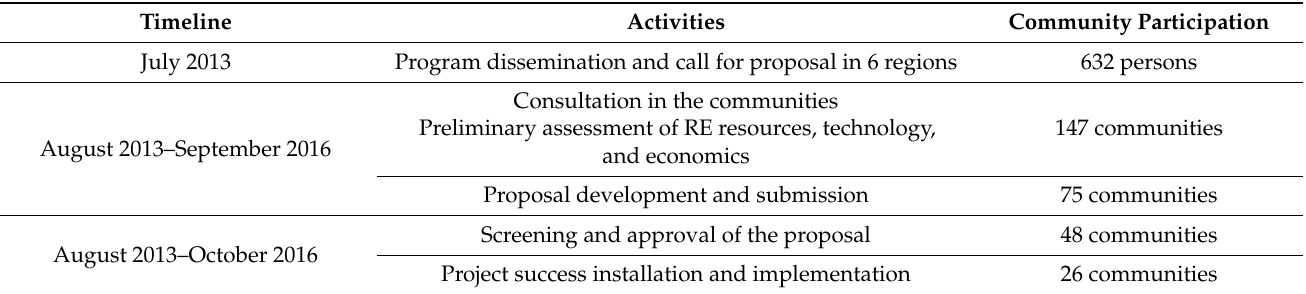
Table 1. Schedule of the CRE subsidy program in